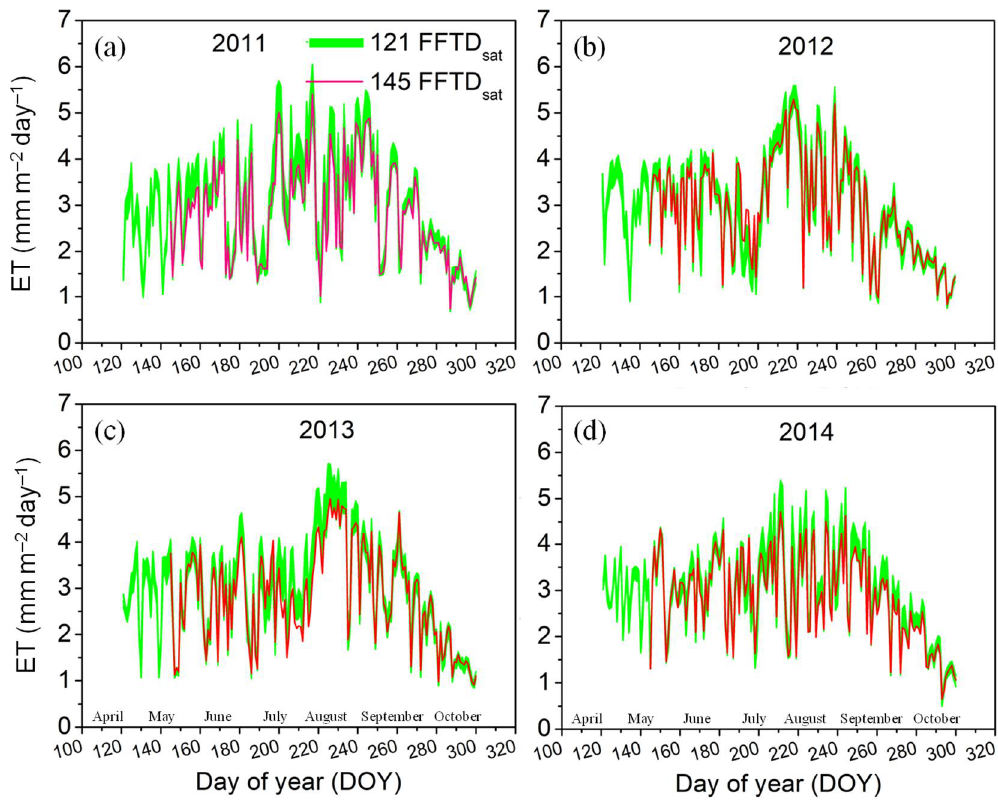
Figure 5. Seasonal courses of daily ET (mm m −2 day −1 ) in paddy fields in which the first dates of field flooding and transplanting ( FFTD sat ) were 121 DOY and 145 DOY in 2011 ( a ), 2012 ( b ), 2013 ( c ), and 2014 ( d ). DOY : the day of year.